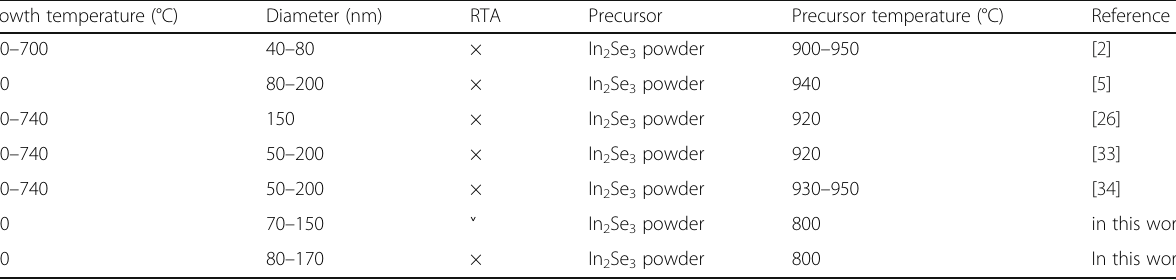
Table 1 Comparison with other works in terms: growth temperature, precursor temperature, and nanowire diameters Growth temperature (°C) Diameter